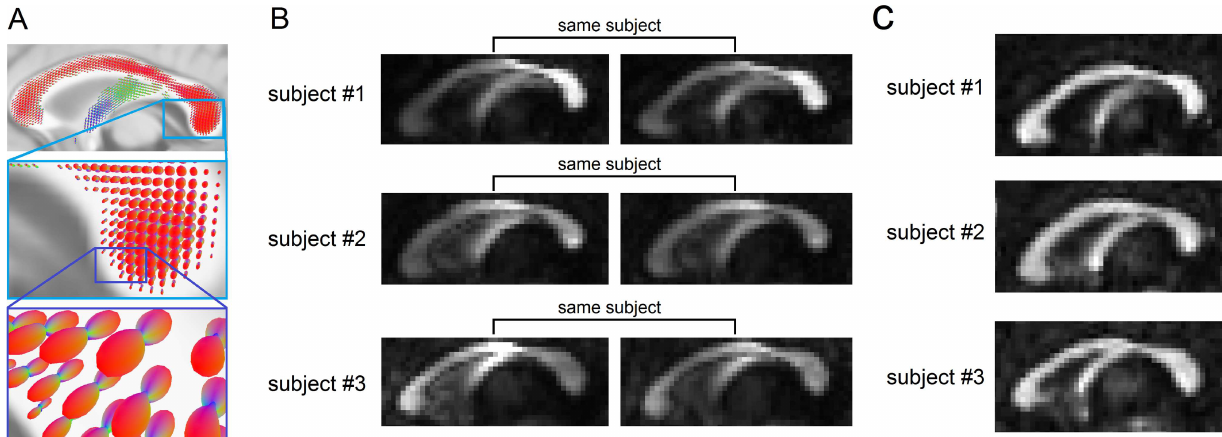
Fig 1. The uniqueness of local connectome structure revealed by the density of diffusing water. (A) The spin distribution function (SDF) calculated from diffusion MRI quantifiesthe density of diffusing water along axonal fiber bundles. The magnitudesof the SDF at axonal directions providedensity-basedmeasurements to characterize axonalfiber bundles. (B) The density measurements obtainedfrom the SDFs show individuality between-subjects #1, #2, and #3 (intensity scaled between [0 0.8]). The density of diffusing water varies substantially across different portions of the corpus callosum. The repeat measurements after 238 (subject #1), 191 (subject #2), and 198 (subject #3) days present a consistent pattern that captures individualvariability. (C) In contrast to the SDF shown in (B), the fractional anisotropyderived from diffusivity shows no obvious individuality between the same subjects #1, #2, and #3 (intensity also scaled between [0 0.8]). This is due to the fact that diffusivity, which quantifies how fast water diffuses, does not vary a lot in normal axonal